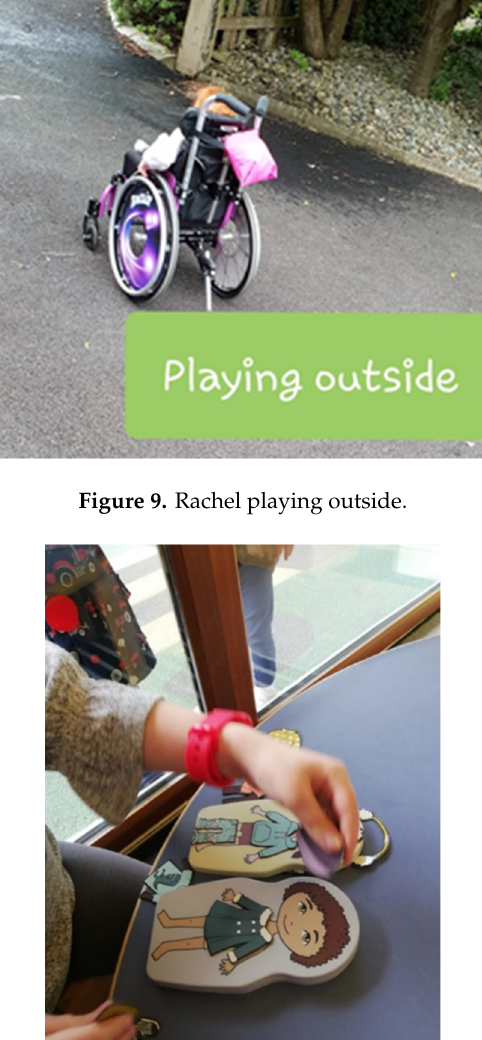
Figure 10. Alice showing her watch to friends at playschool.